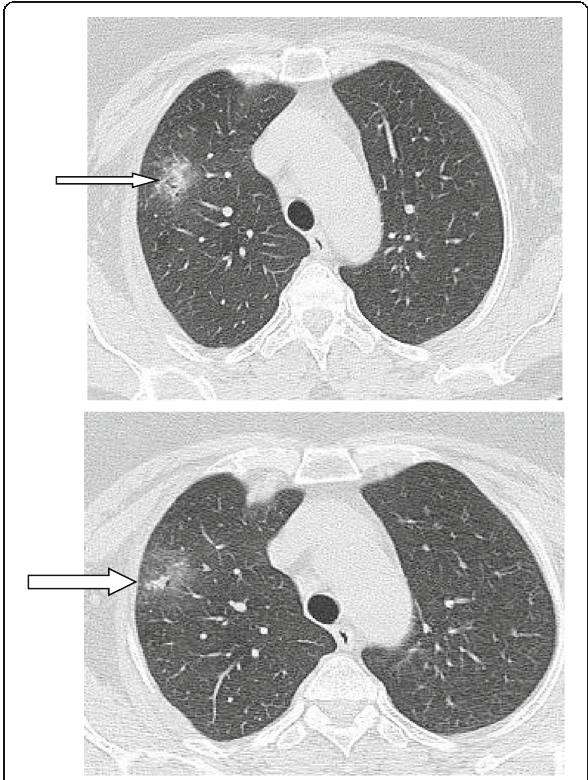
Fig. 16 Another patient with patches of ground glass infiltration and halo